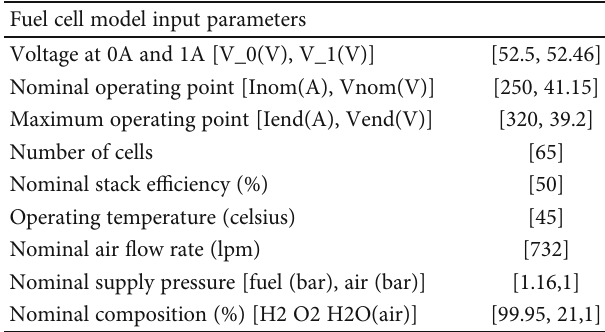
Table 1: Fuel cell model parameters. Fuel cell model input parameters